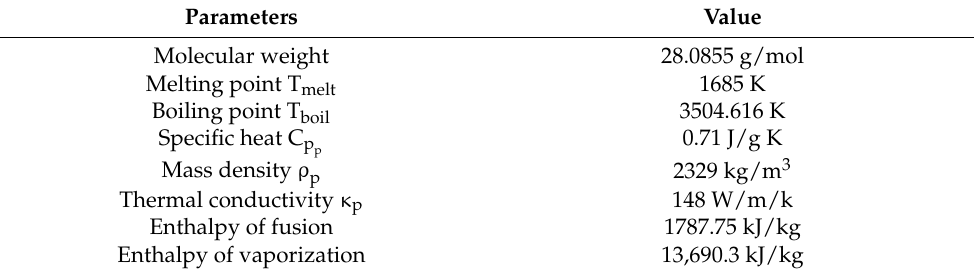
Table 2. Thermophysical characteristics of silicon particles.